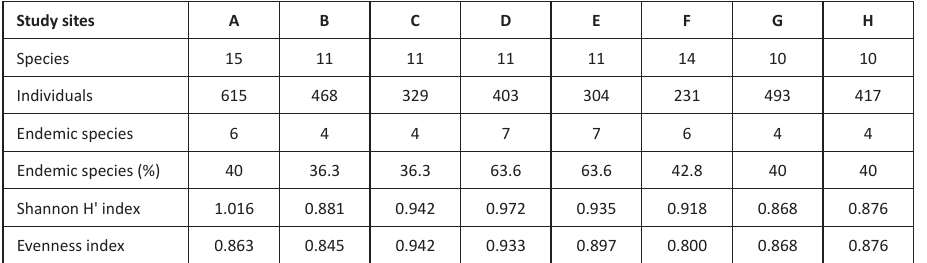
Table 4. Variation in species abundance, endemism, Shannon index and evenness index at various study locations in PWS. Study sites A B